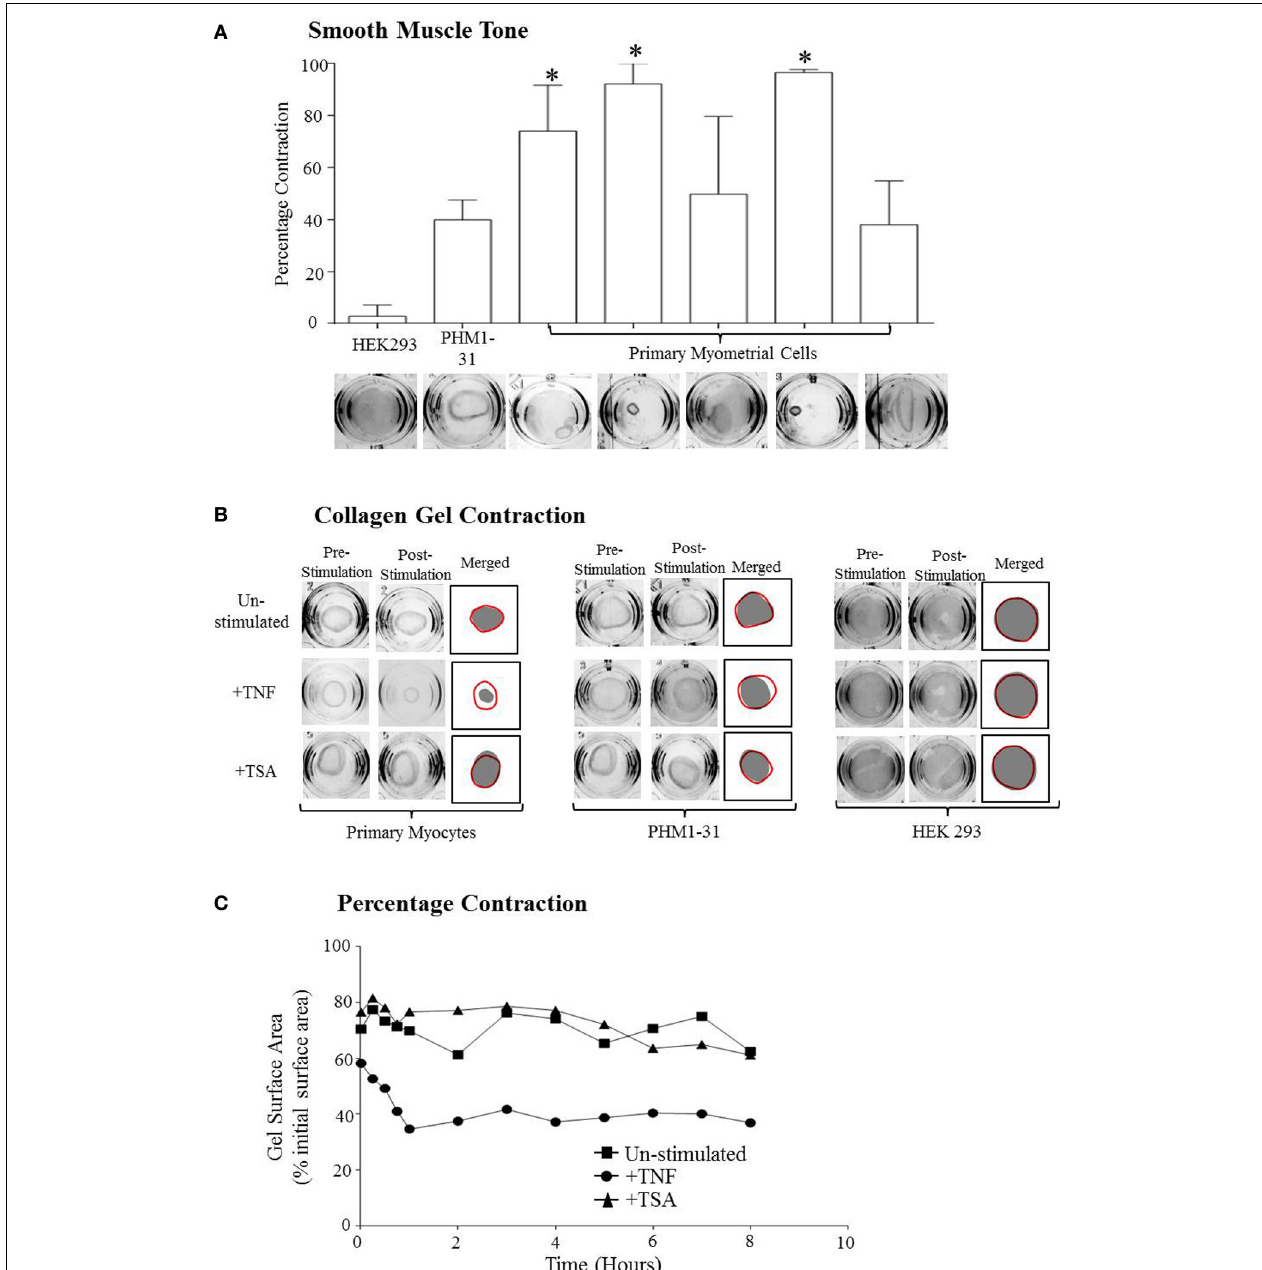
FIGURE 2 | Primary myometrial cell cultures retain smooth muscle tone and the ability to contract. (A) The reduction of the surface area of the collagen after release demonstrates the retention of smooth muscle tone in the primary myometrial cell cultures. In the more confluent cultures this